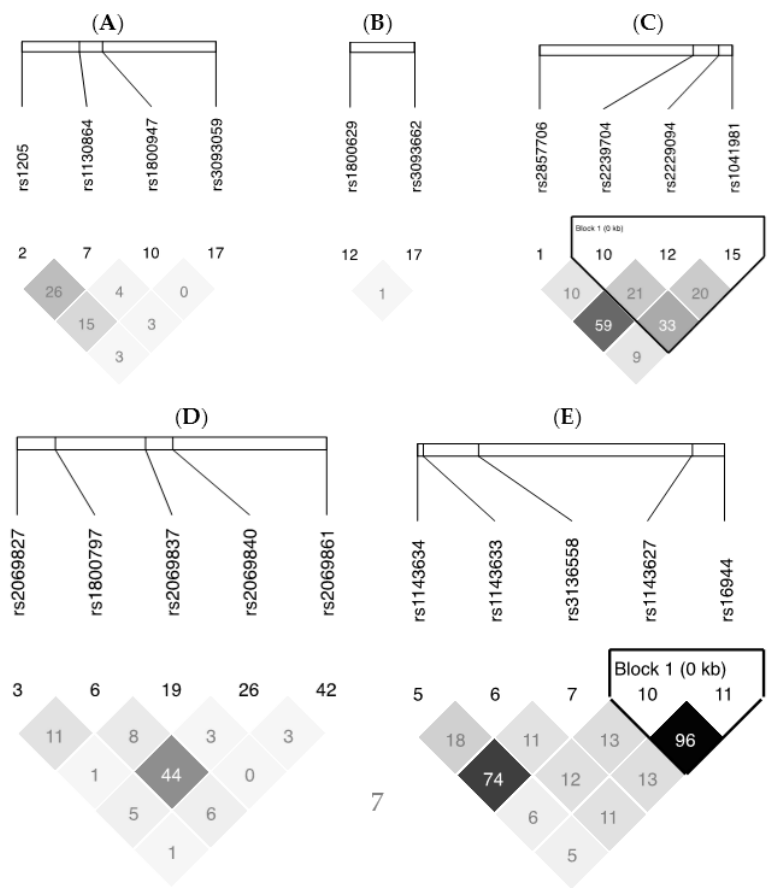
Figure 3. LD plots of selected inflammation-related genes. The lighter the shade of grey, the lesser is the correlation between two SNPs. ( A ) CRP gene; ( B ) TNF - α gene; ( C ) LTA gene; ( D ) IL6 gene; ( E ) IL-1 β gene.